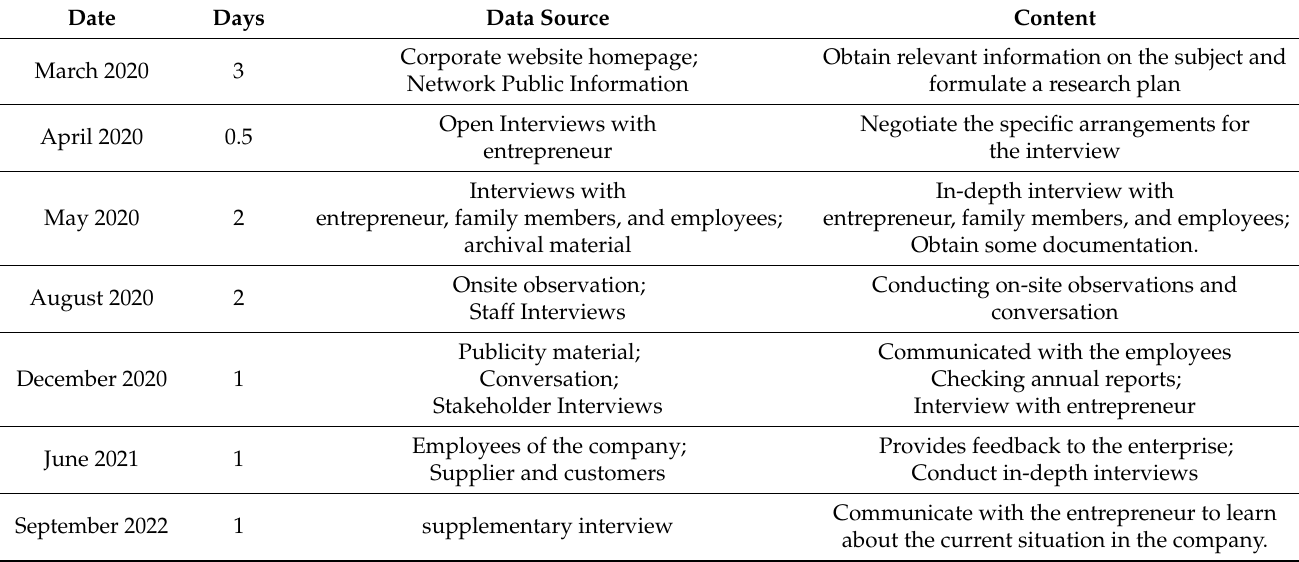
Table 1. Details of data